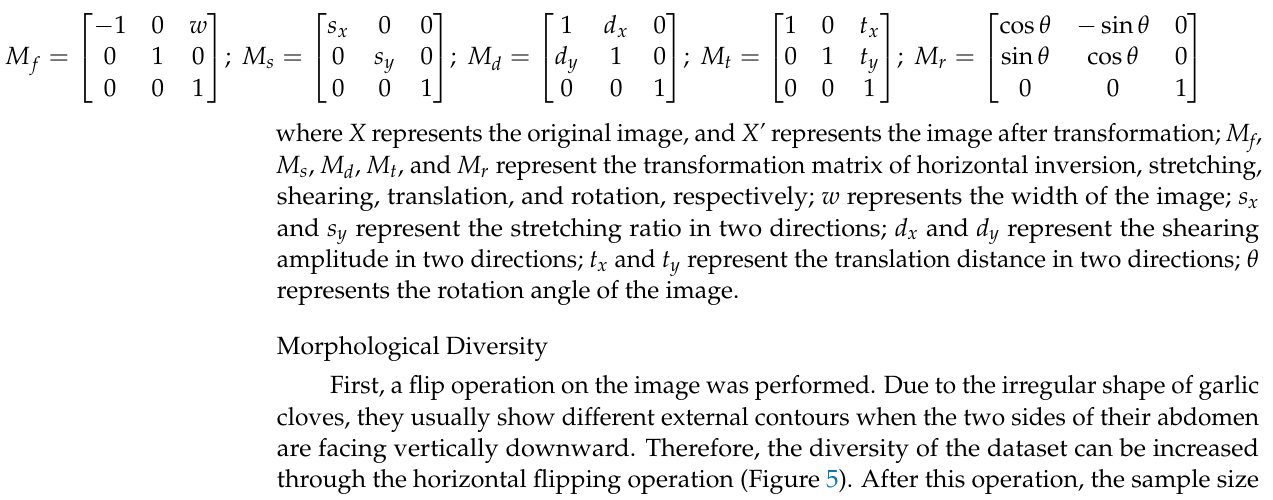
Figure 6. Stretching, shearing, and translation.